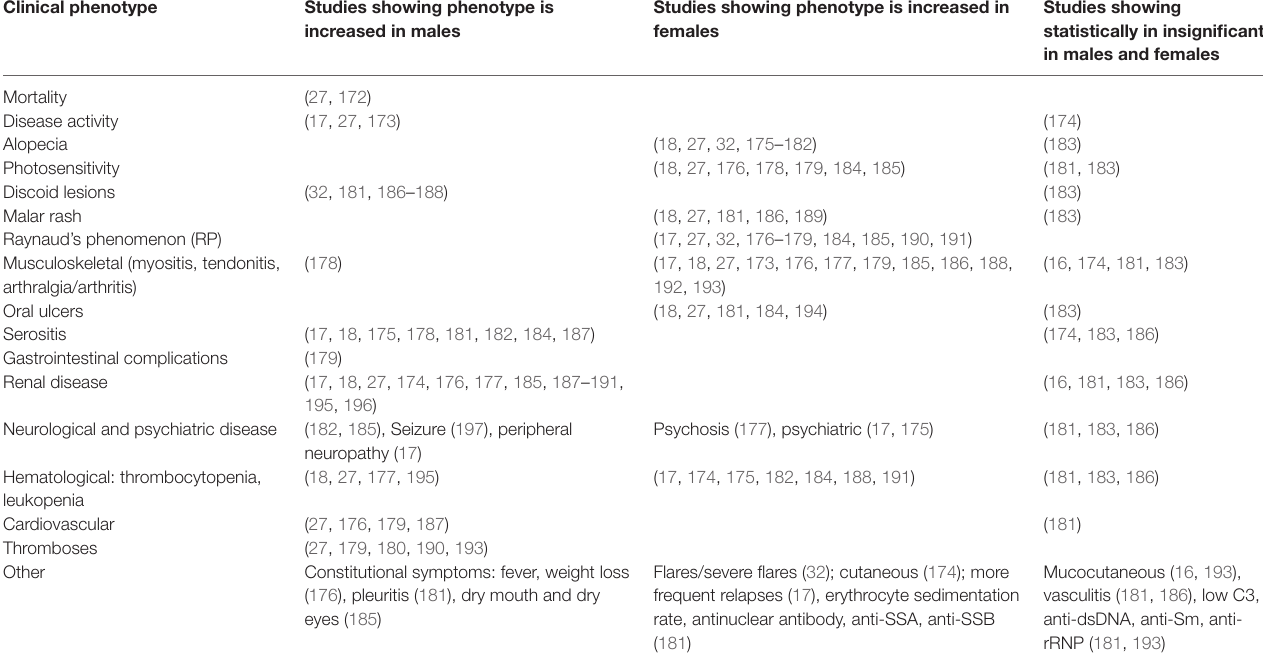
taBLe 3 | Sex differences in systemic lupus erythematosus clinical